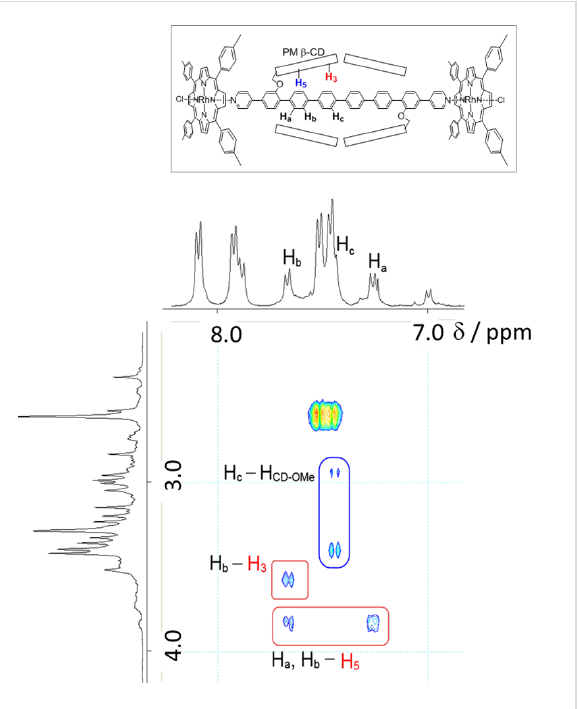
Figure 6: Partial ROESY NMR spectrum of 26 (400 MHz, CDCl 3 ) showing the NOEs between aromatic protons of the axial hexa( para - phenylene) and inner protons of